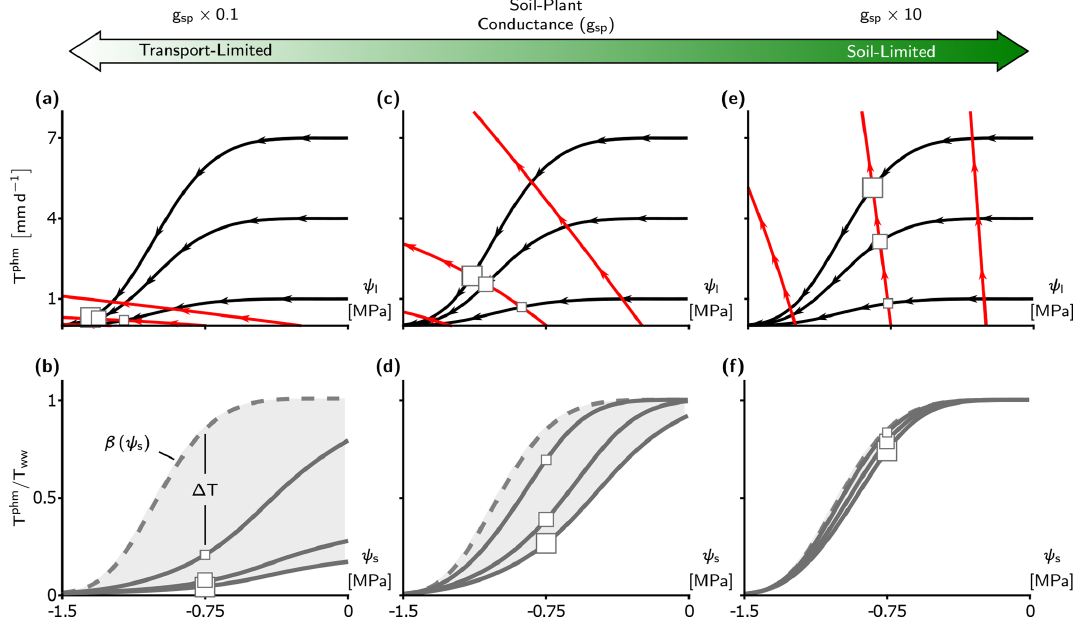
Figure 4. Transport-limitation spectrum observed in the complex PHM formulation. (a, c, e) Supply–demand curves for three values of soil– plant conductance, g sp , using the complex PHM formulation. Panel (c) uses the calibrated LSM parameters from the US-Me2 AmeriFlux site discussed in Sect. 2.3. Panels (a) and (e) contain the calibrated conductance ( g sp ≈ 13mmd − 1 MPa − 1 ) multiplied by 0.1 and 10, respectively. The supply lines (red) are shown at ψ s equal to 0, − 0 . 75, and − 1 . 5MPa, and demand lines (black) are shown at T ww equal to 1, 4, and 7mmd − 1 . The PHM solution for ψ s at − 0 . 75MPa is shown by the squares with size corresponding to T ww magnitude. (b, d, f) The relative transpiration for the PHM (solid) in panels (a) , (c) , and (e) and the infinitely conductive β solution (dashed line) are shown. The light gray shading indicates the PHM downregulation envelope bounded by β(ψ s ) as T ww approaches zero and the relative transpiration curve at the highest T ww